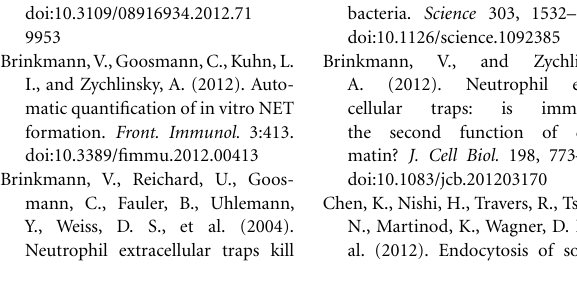
FIGURE 7 |Alu-I-derived NETs retain microbicidal activity partially dependent on DNA integrity . S. aureus, E. coli C1845, S. flexneri , and S. enterica serovar Typhimurium SL1344 were incubated for 45min in the presence of isolated NETs obtained after Alu I treatment of A23187- or PMA-activated PMN. In some experiments, NET samples were pretreated